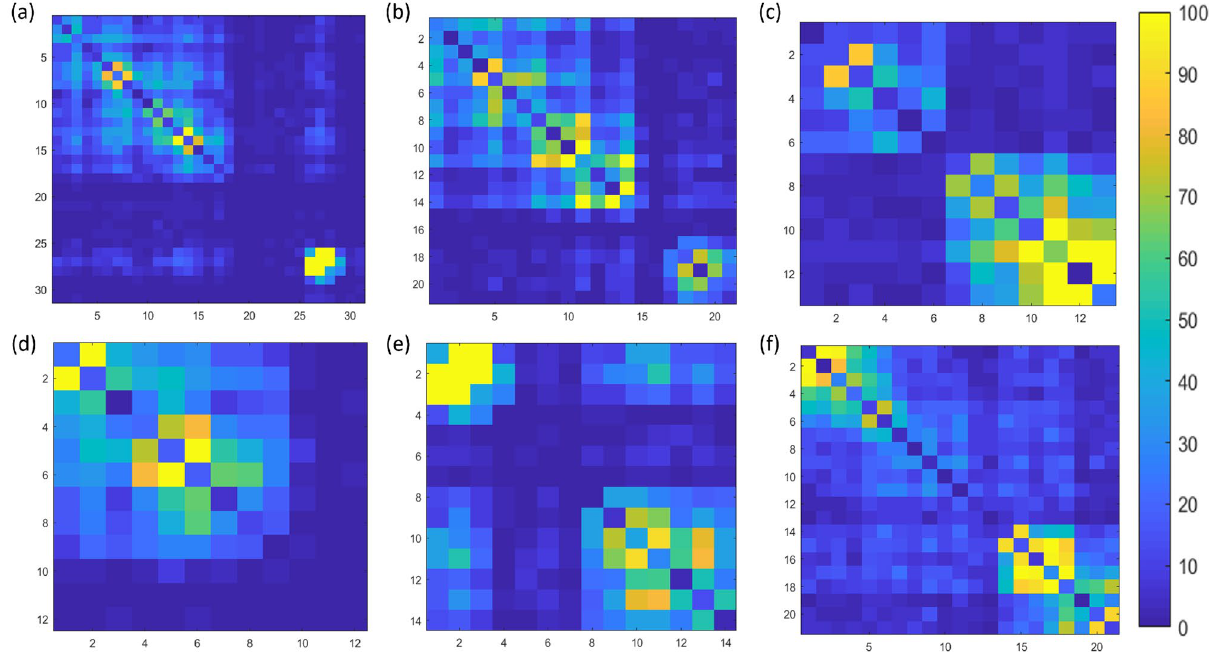
Figure 10. The illustration of six different non-TAD regions of human ES (embryonic stem) chromosome 10. The contact frequency values are represented by colors. Bright yellow color indicate higher contact frequency, thus a short Euclidean distance between the two loci. As listed in Table 3, the AI values for non-TAD regions ( a – f ) are dramatically low as compared to the AI values for TADs.